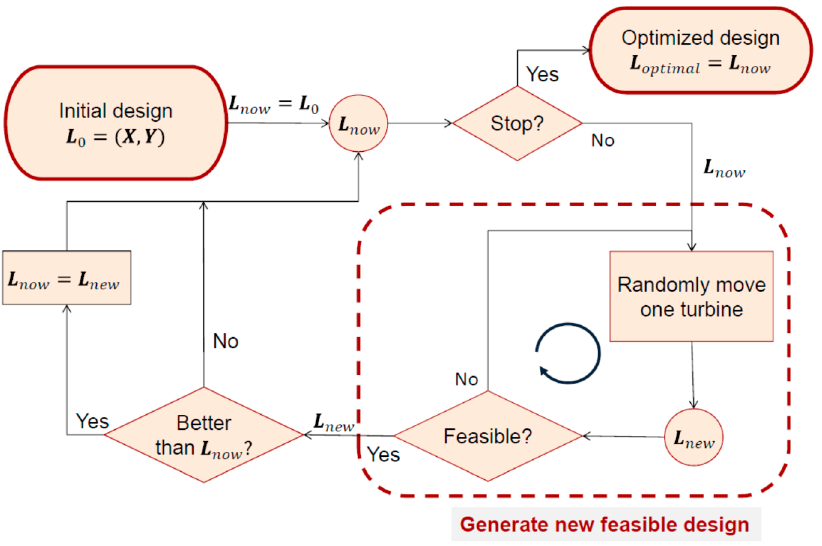
Figure 4. Flowchart of the Random Search algorithm.